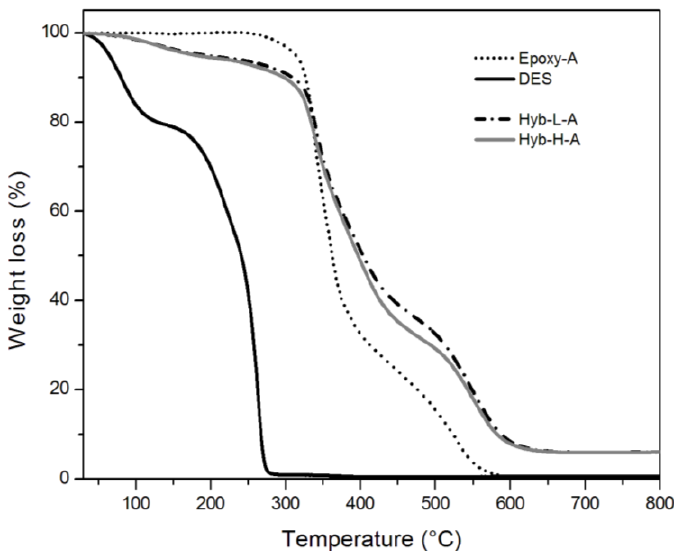
Figure 8. TGA thermograms of Epoxy-A and Hyb-H-A systems heated at 10 °C/min in oxidant atmosphere.